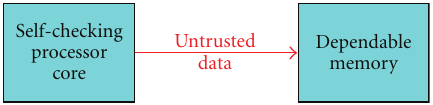
Figure 1: Untrusted data flowing into DM.